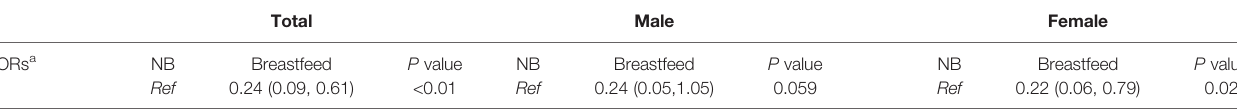
TABLE 4 | The association between breastfeed and infant overweight or obesity (BMI ≥ 85th percentile).